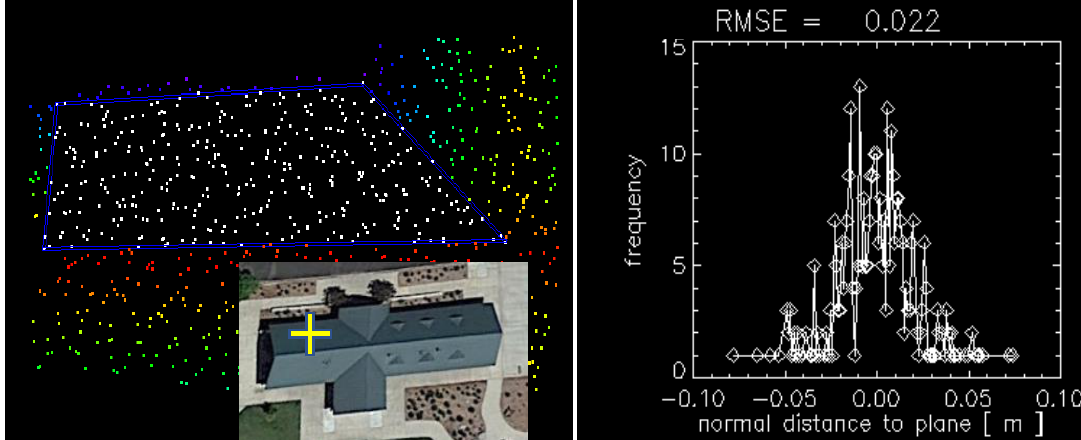
Figure 7. Illustration of intraswath smooth surface precision.